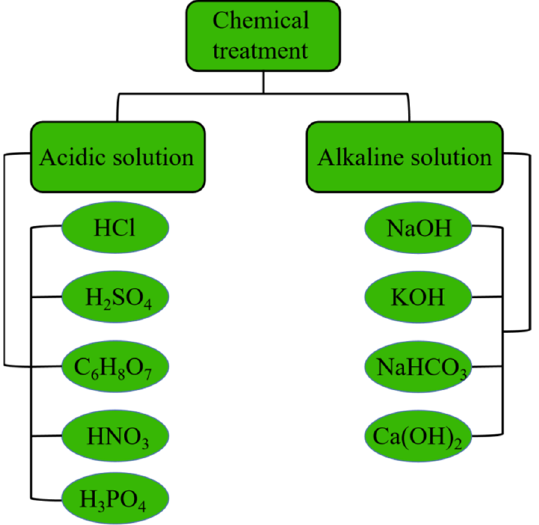
Figure 3. Several chemicals commonly used to modify biochar [89]. Adapted with permission from KhaledZoroufchi Benis et al. (2020). Copyright 2020, Elsevier.